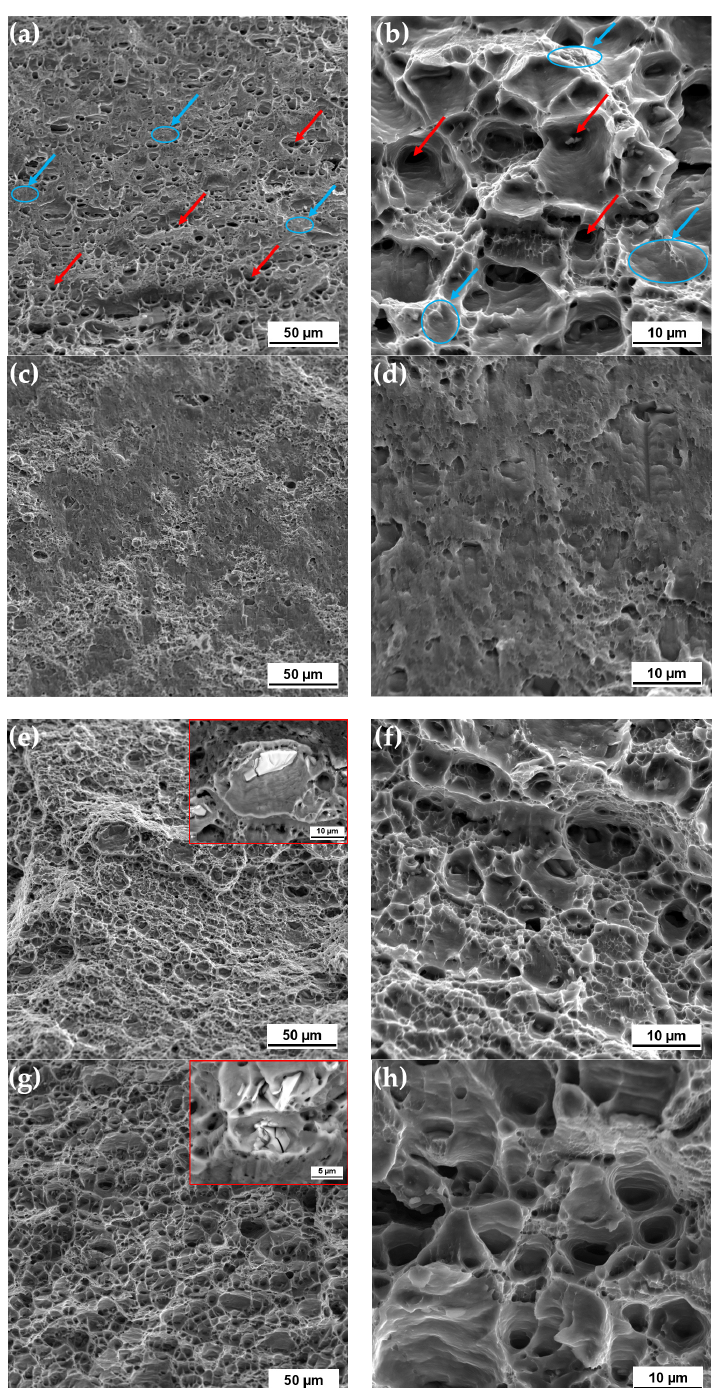
Figure 6. Fracture topography of AA6082-T6 joints: ( a ) FSW—HAZ (×1000). Dominant ductile fracture with cleavage/quasicleavage fracture areas; ( b ) FSW (×5000). Equiaxial dimples, visible large microvoids with surrounding many fine dimples; ( c ) IFSW 2 kN 3 Hz—center of the SZ (×1000). Ductile-cleavage fracture; ( d ) IFSW 2 kN 3 Hz (×5000). Cleavage fracture, visible cleavage steps; ( e ) IFSW 2 kN 3 Hz—surrounding region of the SZ center (×1000). Mostly ductile fracture with broken intermetallic inclusions (BSE); ( f ) Magnification of region ( e ) (×5000); ( g ) IFSW 2 kN 10 Hz—HAZ (×1000). Mostly ductile fracture with broken intermetallic inclusions (BSE); ( h ) IFSW 2 kN 10 Hz (×5000). Large microvoids with many surrounding fine dimples.